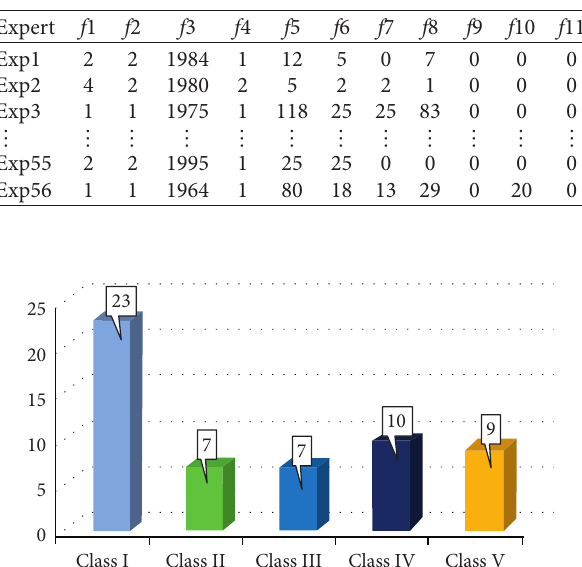
Table 2: Basic data set of experts in the field of algal bloom